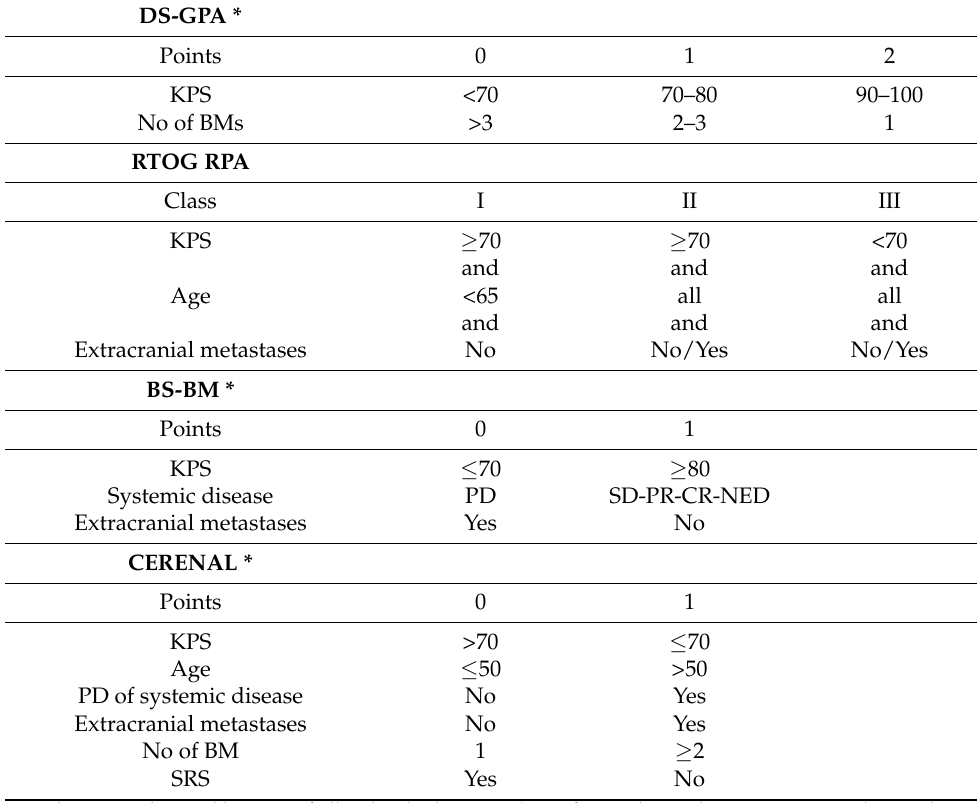
Table 1. Calculation of BMRCC prognostic